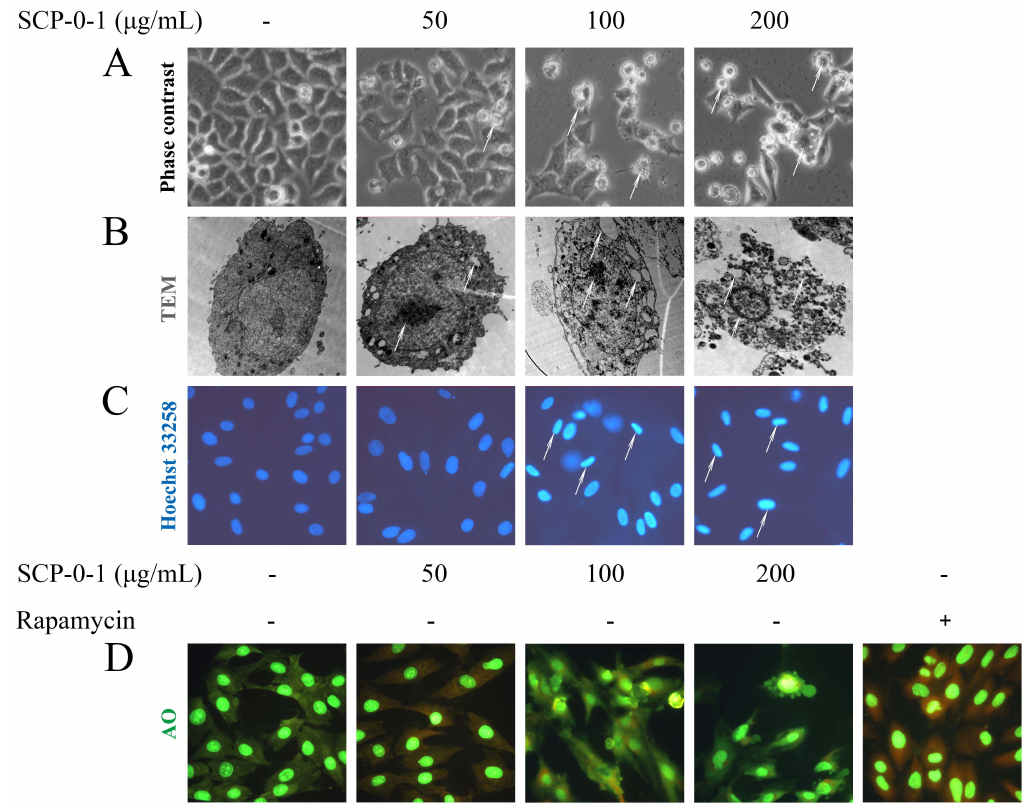
Figure 3. Morphological changes in human hepatocellular liver carcinoma (HepG2) cells after S. Chinensis polysaccharide-0-1 (SCP-0-1) treatment. The morphological observation confirmed